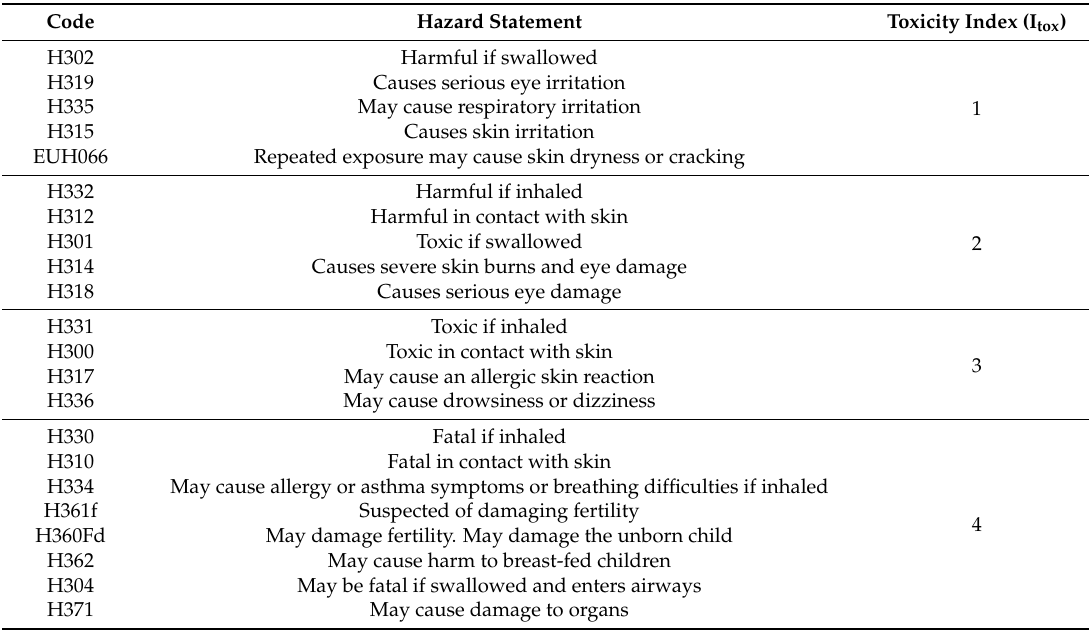
Table 9. List of the toxicity levels based on Regulation (EC) no.